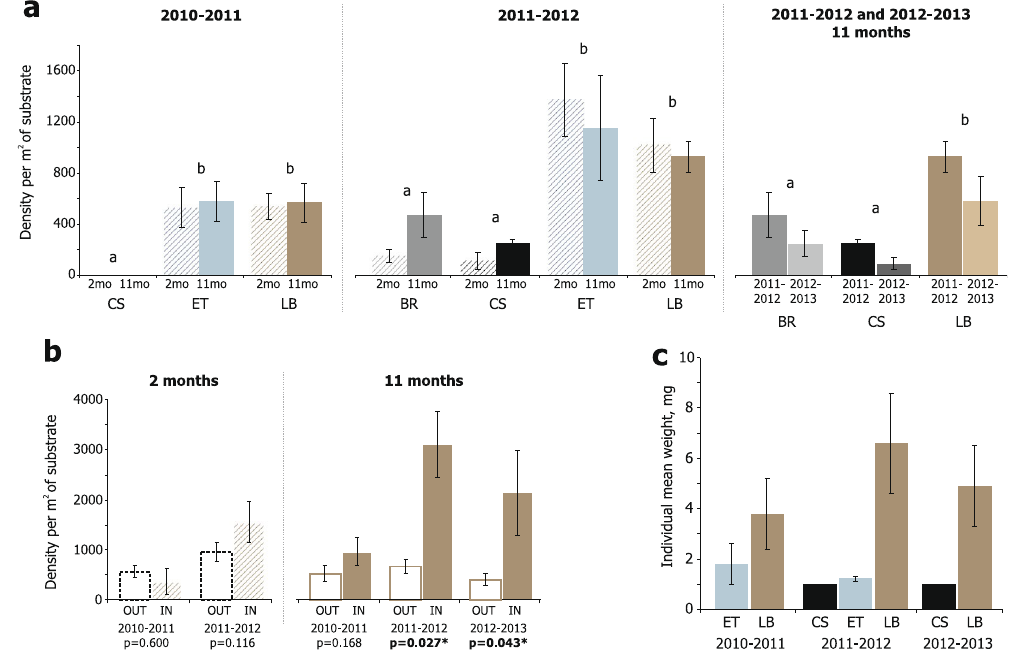
Figure 2. Recruitment of solitary ascidians by substrate type in the substrate manipulation experiment. Mean numbers of ascidian recruits on cockle shells with barnacles removed (BR), empty cockle shells (CS), empty barnacle tests (ET), and live barnacles (LB) with post-hoc test results indicated by lettering ( a ) (analyses of the data given in Table 1). Mean numbers of ascidian recruits on live barnacles inside (IN) and outside (OUT) the orifice per 1 m 2 of substrate surface by year and exposure term pairwise compared by Wilcoxon matched pairs test ( b ). Mean individual weights of ascidian recruits on cockle shells (CS), empty barnacle tests (ET), and live barnacles (LB), exposed for 11 months ( c